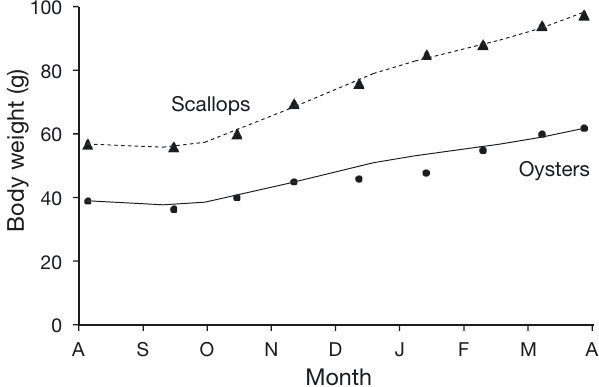
Fig. 3. Comparison between the observed (dots and trian- gles) and simulated (solid and dashed lines) growth of sea cucumber Apostichopus japonicus in the co-culture environ- ment during August 2000−April 2001. Solid and dashed lines are the modelled body weight from co-cultures with oysters Crassostrea gigas and scallops Chlamys farreri , respectively